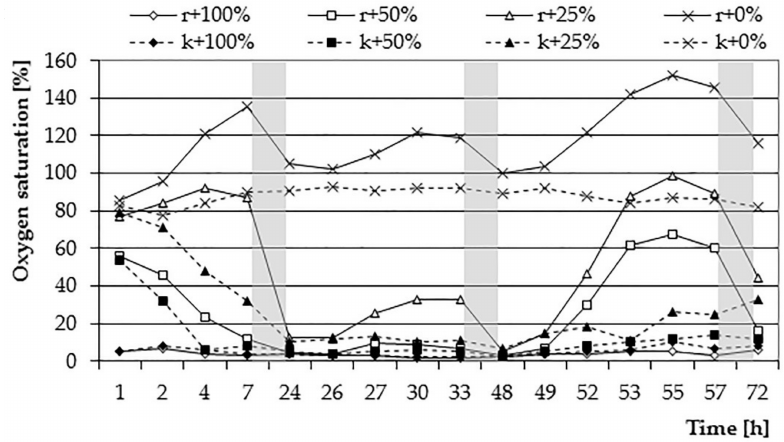
Figure 4. The average percentage of oxygen saturation of wastewater solutions (0, 25, 50, and 100%) with and without (control) E. densa within 3 days of analyzes (periods of nighttime—without measurements—marked as grey